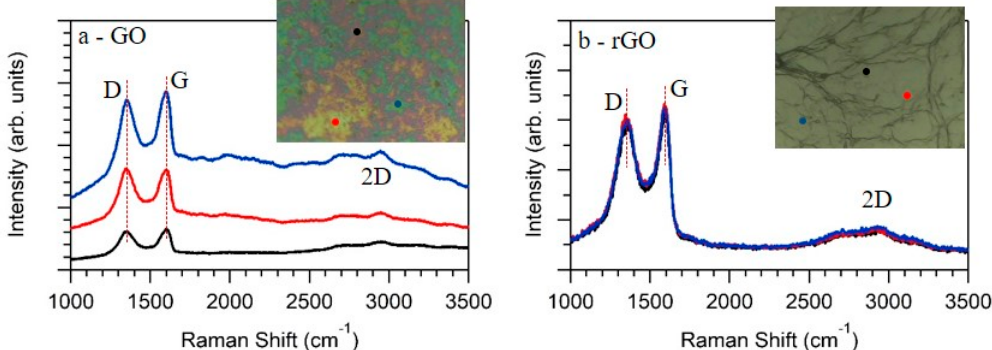
Figure 3. As measured Raman spectra obtained at different points of the GO ( a ) and rGO ( b ) films. The insets show the optical images of the samples, while the red, blue, and black dots indicate the position in which the respective Raman spectra were acquired.